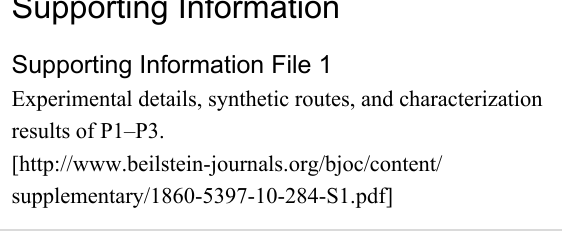
denced by the R 2 values which were close or equal to